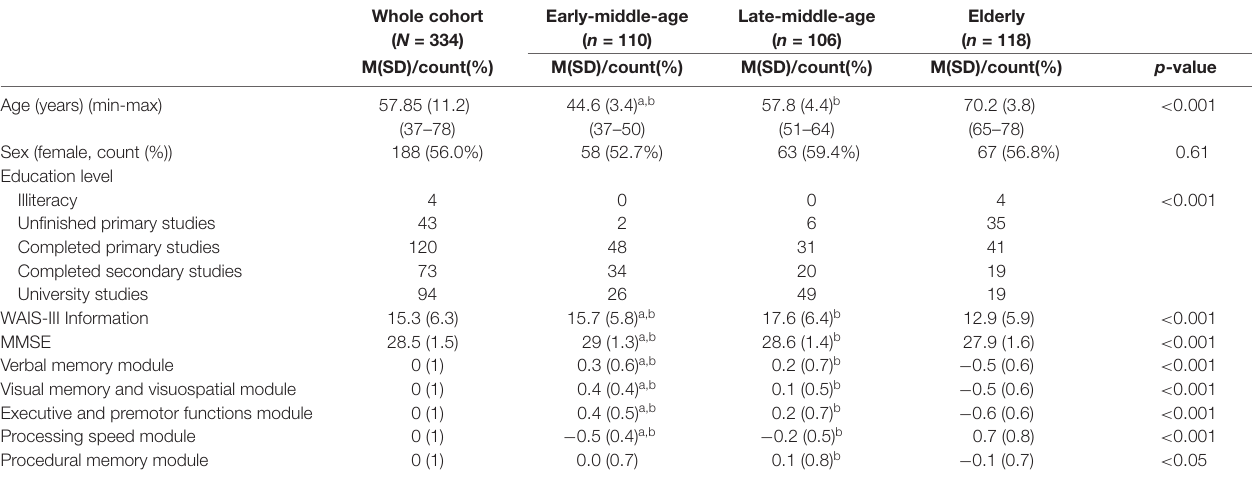
TABLE 2 | Key characteristics of the whole cohort and the three age groups.